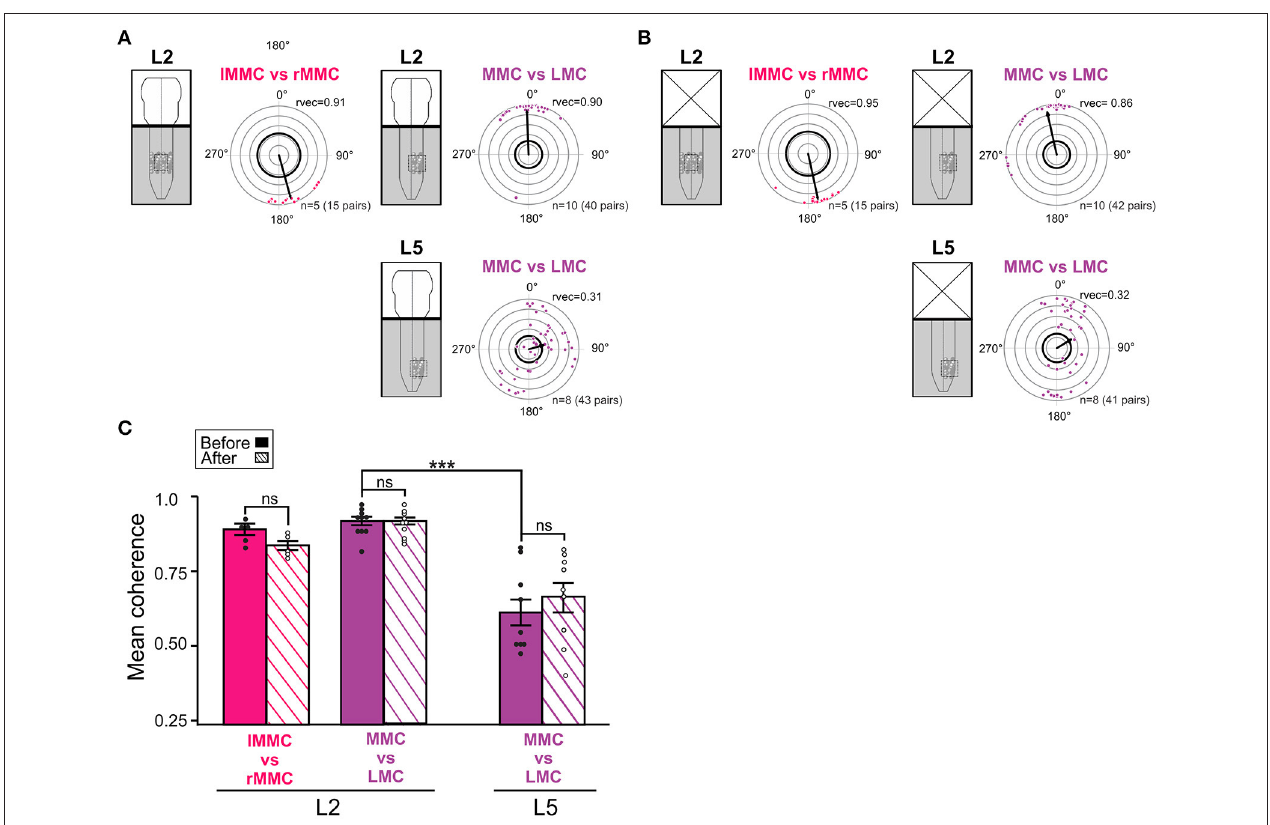
FIGURE 5 | Temporal relationships and coupling strengths between MNs of different motor columns before and after removal of the brain stem. (A,B) Inter-columnar phase relationships between pairs of MNs in left and right MMC in L2, MMC and LMC in L2, and MMC and LMC in L5 before and after removal of the brain stem. Phase relationships between MMCs are shown in red and phase relationships between MMC and LMCs are shown in purple. Removal of the brain stem did not significantly change the mean phase differences between MNs (Watson–Williams F -test, L2 lMMC/rMMC before vs. lMMC/rMMC after F = 0.03, p = 0.87; L2 MMC/LMC before vs. MMC/LMC after F = 0.60, p = 0.45; L5 MMC/LMC before vs. MMC/LMC after F = 0.21, p = 0.65). (C) Bar graph showing mean coherence before (solid bars) and after (hatched bars) removal of the brain stem. The strengths of the coupling between MNs was not significantly affected by removal of the brain stem (Wilcoxon matched-pairs test, L2 lMMC/rMMC before vs. lMMC/rMMC after p = 0.19; Kruskal-Wallis test followed by a Dunn’s multiple comparison, L2 MMC/LMC before vs. L2 MMC/LMC after p > 0.99; L5 MMC/LMC before vs. L5 MMC/LMC after p > 0.99). *** p < 0.001. For other details, see Figure 4